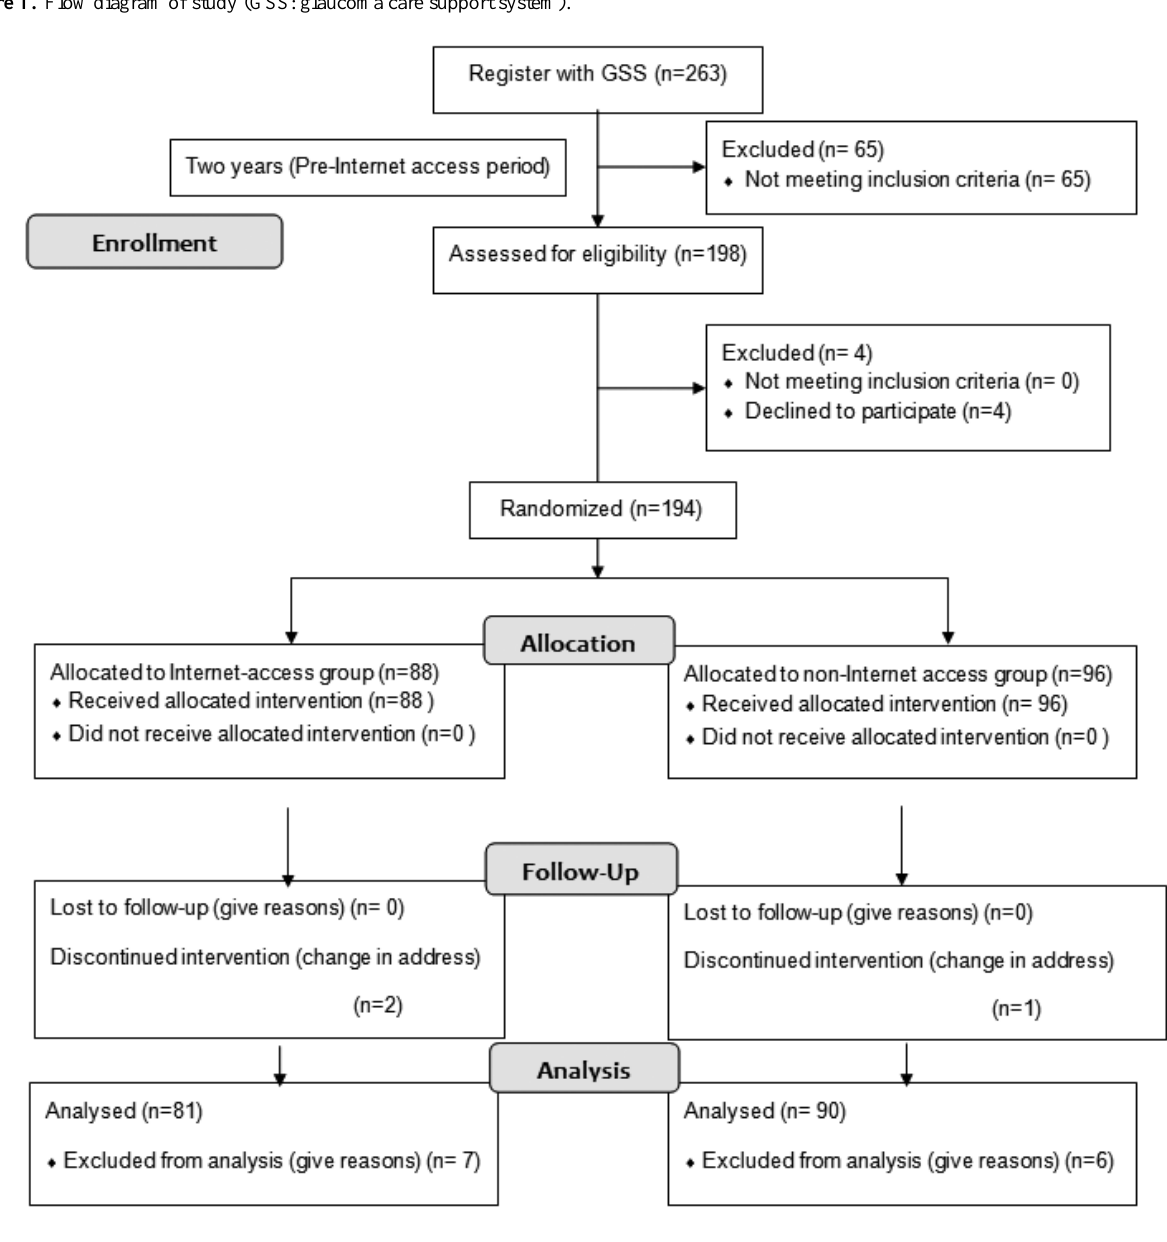
Figure 1. Flow diagram of study (GSS: glaucoma care support